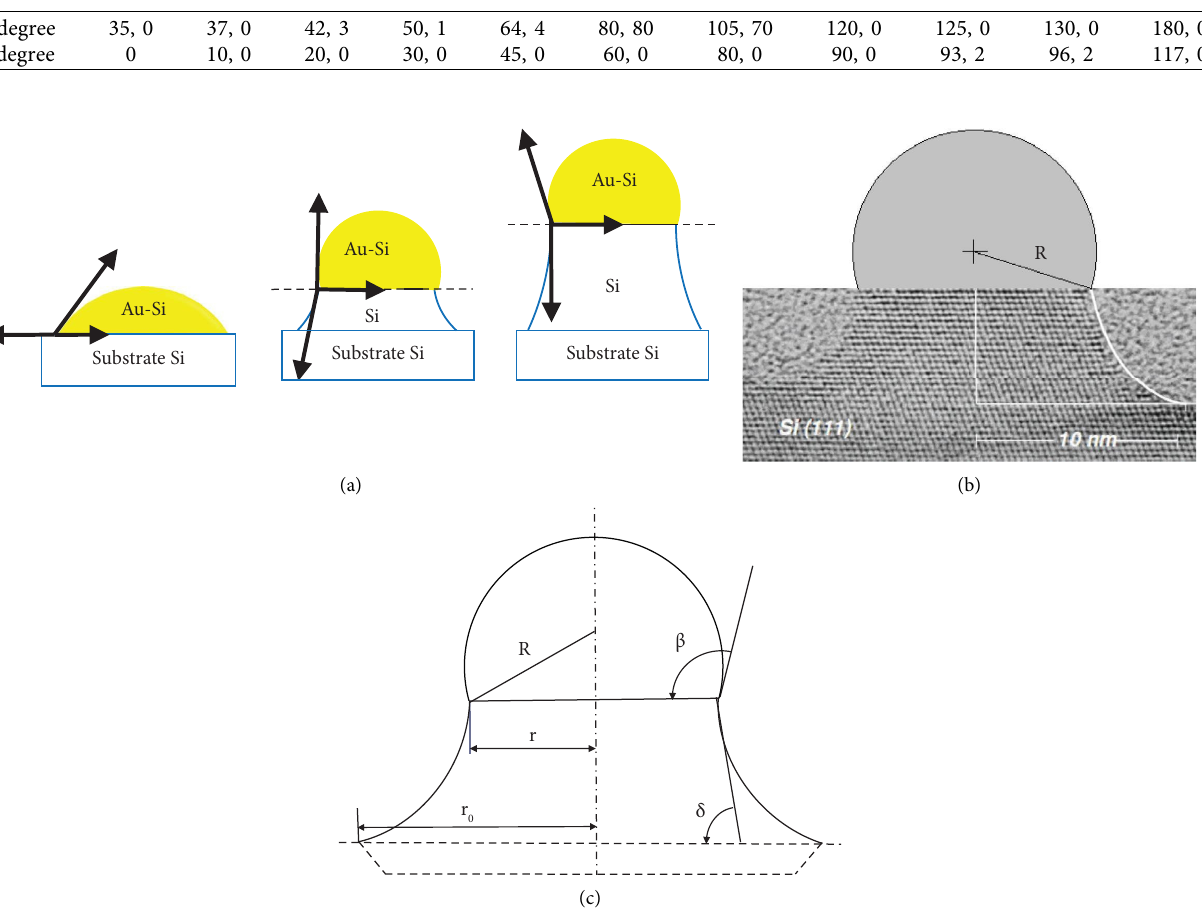
Figure 4: Te sequence of stages of the formation of NWs pedestals in the Au-Si system in the Au-Si system (a), high-resolution electron microscopic image (JEM-4010) of the initial cone-shaped section of Si NWs epitaxial growth [21] (b), and a schematic representation of NWs at the initial stage of VLS growth value. Figure 5 is a SEM image illustrating the wavelike profle of the side surface of silicon NWs.